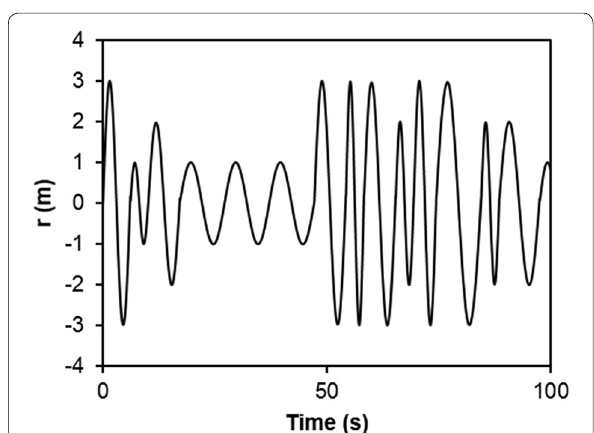
Fig. 11 Free vibration response of the system. Time-domain and frequency domain response of the buoy structure to an initial pitch displacement of 10°